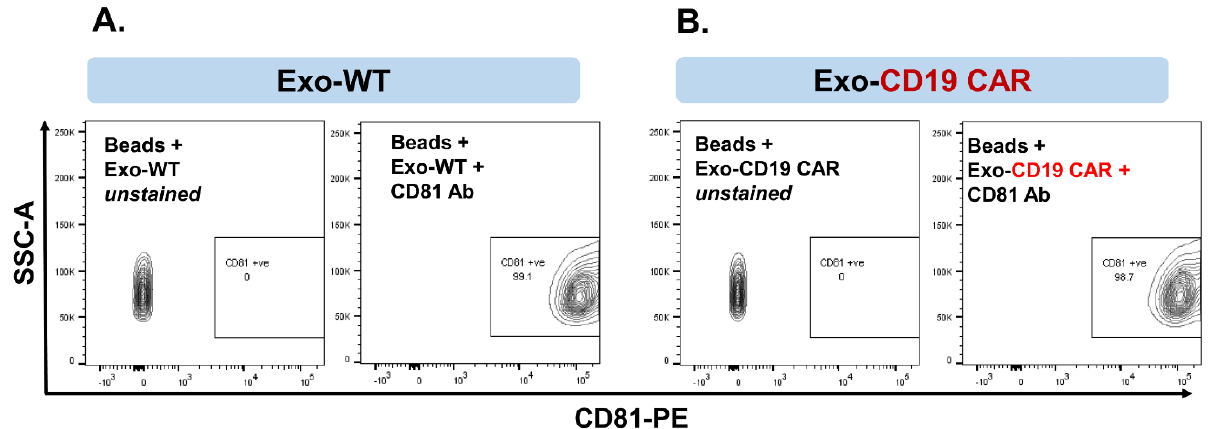
Figure 3. Characterization of purified exosomes. ( A ) Confirmation of CD63 and CD81 expression on exosomederived from the conditioned medium of HEK293T-WT by flow cytometry (contour plot). ( B ) Confirmation of CD63 and CD81 expression on exosomes derived from the conditioned medium of HEK293T-CD19 CAR by flow cytometry (contour plot).